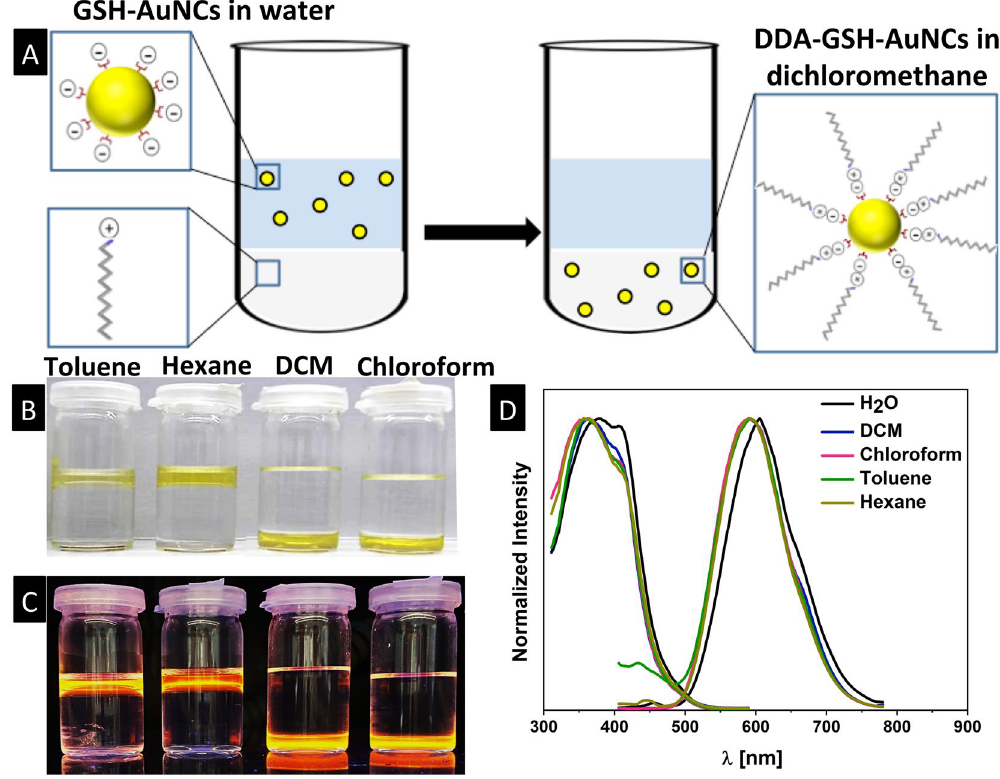
Figure 2. ( A ) Sketch shows hydrophobic ion pairing (between negatively charged carboxylic acid groups on GSH-AuNCs and positively charged amine groups on dodecylamine) and transfer of the resulting DDA-GSH- AuNCs from water to dichloromethane. ( B ) Digital photograph of vials contain biphasic system of water (clear layers) and immiscible organic solvents (yellowish layer, as labeled) contain transferred